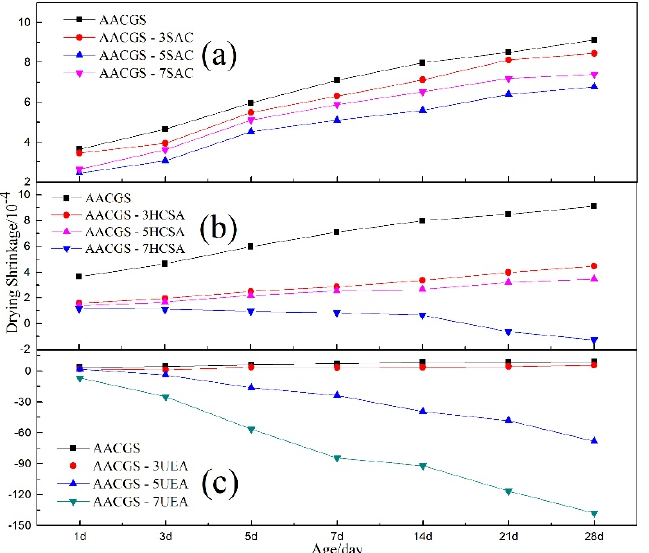
Figure 2. Influence of additives on the drying shrinkage of AACGS. ( a ) Drying shrinkage of AACGS with SAC, ( b ) drying shrinkage of AACGS with HCSA and ( c ) drying shrinkage of AACGS with UEA.